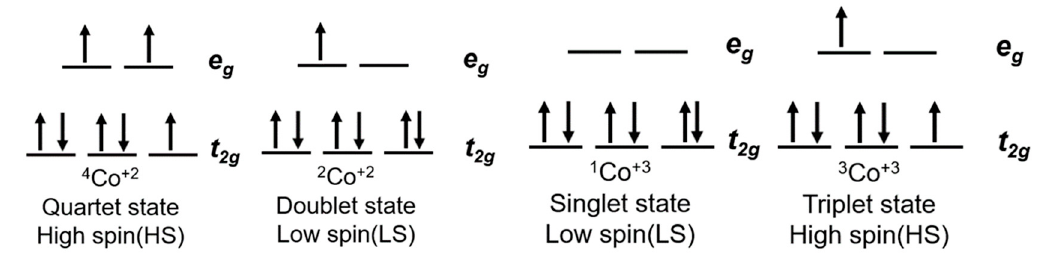
Figure 3. Electronic configuration of the cobalt(III)/(II) couple as well as ligand field theory diagram.